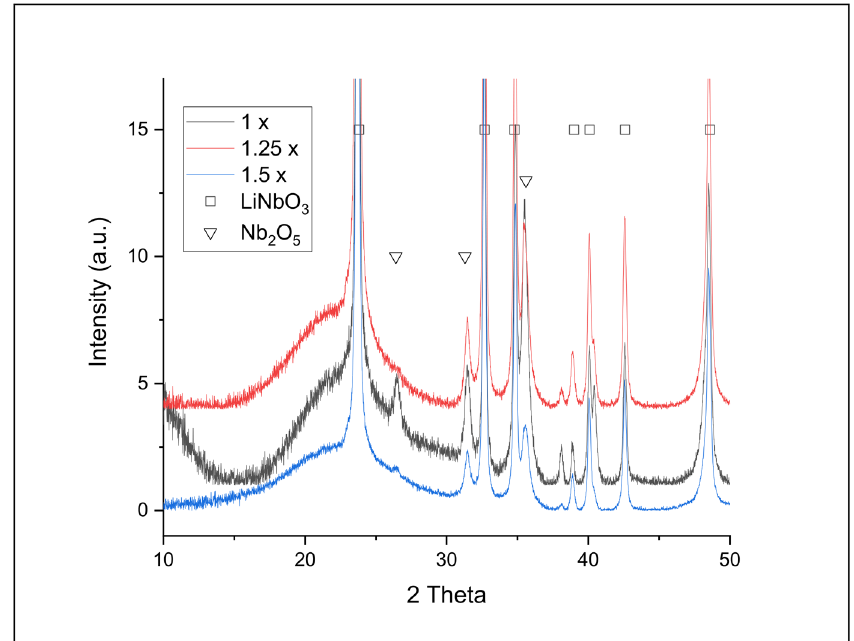
Figure 6. Effect of the Li excess on the chemical synthesis of LN showed through XRD diffractograms (the fixed parameters for the synthesis of different samples were as follows: diethylene glycol solvent, 72 h reaction time).